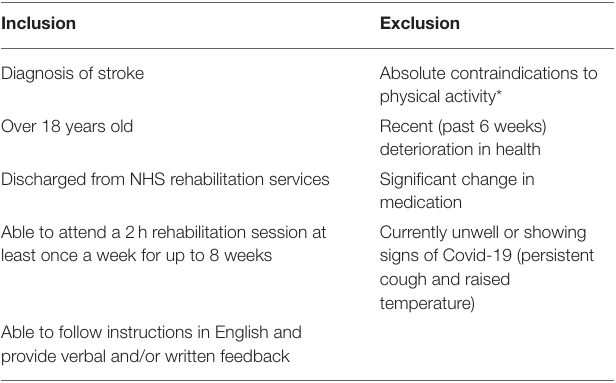
TABLE 2 | Eligibility criteria.